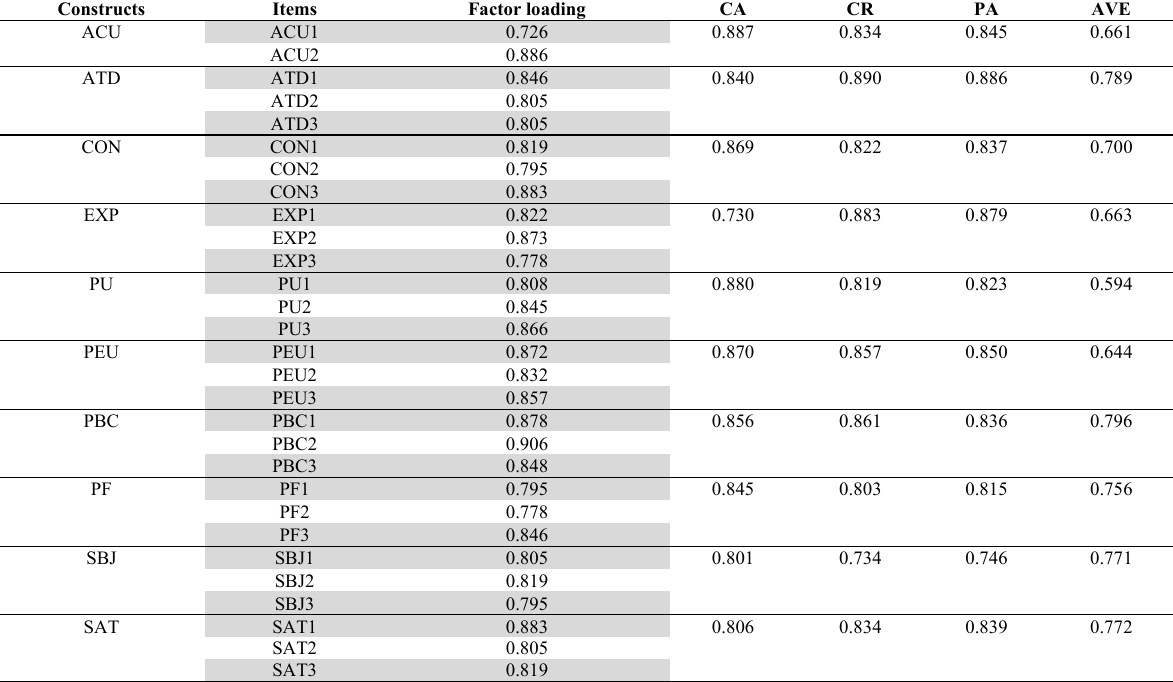
The convergent validity outcomes Constructs